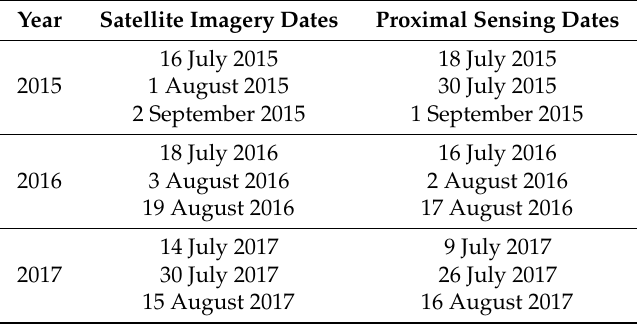
Table 2. Dates of acquisition of satellite and proximal sensing